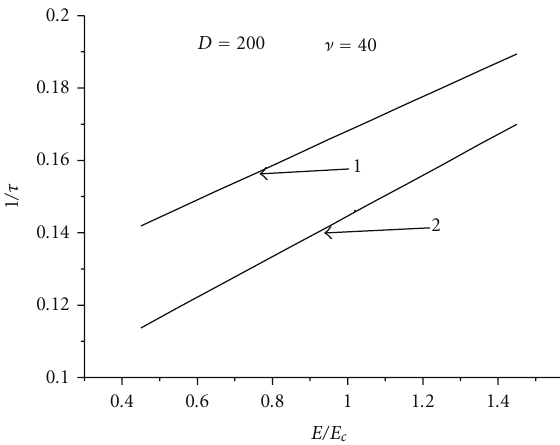
Figure 1: Switching rate, 1/ τ (in units of β 2 / ( γη )), from the metastable ferroelectric state to the second metastable ferroelectric state (for the reduced dimensionless temperature δ = ( T − T 0 ) / ( T c − T 0 ) = 1 . 330, curve 1) and from the first stable ferroelectric state to the second stable ferroelectric state (for δ = 0 . 7407, curve 2) for the 2D system as a function of the dimensionless applied electric field E/E c ; E c is the coercive field. The number of dipoles is N = 64 × 64. The initial state corresponds to the ferroelectric state with a nucleus of the second ferroelectric domain with the dipoles oriented in the opposite direction (the size of the nucleus is 4 × 4). Parameters of the calculation are chosen in accordance with the data for BaTiO 3 : the coe ffi cient of the dipole-dipole interaction is D = 200; the coe ffi cient of the interaction between nearest neighbours is ν = 40 . These coe ffi cients are taken from the dielectric and structure measurements in BaTiO 3